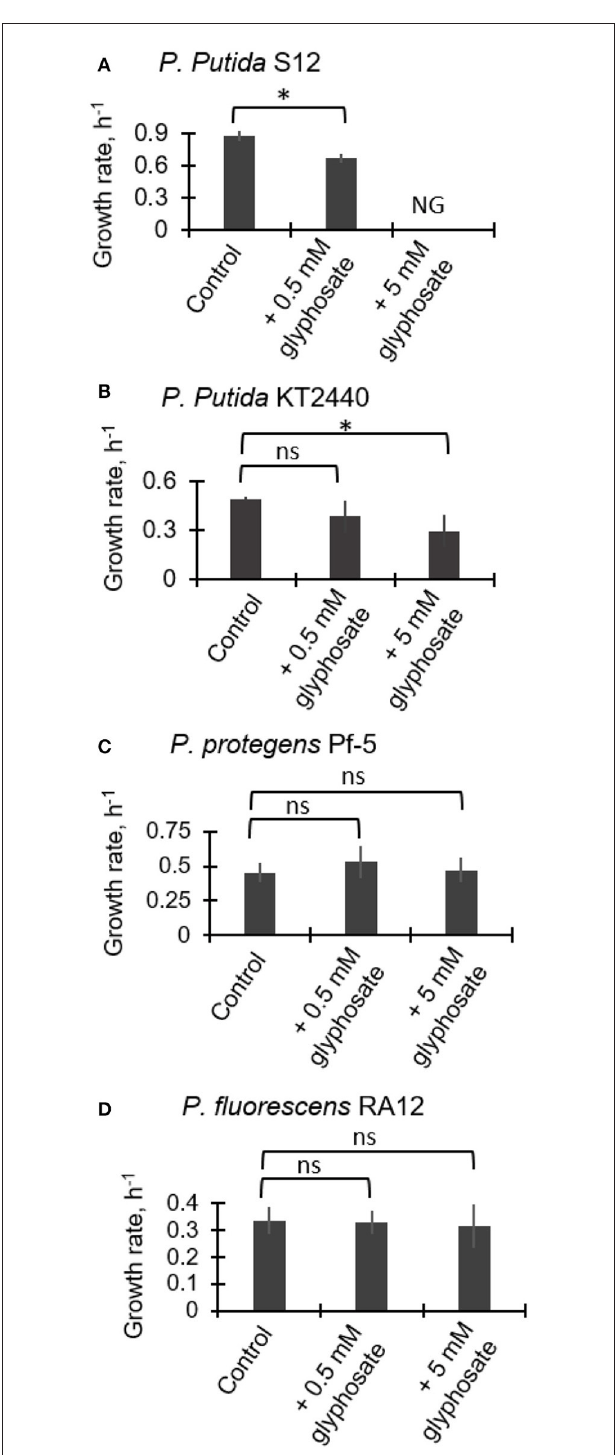
FIGURE 2 | Growth rates of succinate-grown Pseudomonas species in the absence (control) and presence of glyphosate (0.5mM and 5mM): (A) P. putida S12; (B) P. putida KT2440; (C) P. protegens Pf-5; (D) P. fluorescens RA12. Abbreviation for (B) : NG, no growth. The measured data were from three biological replicates ( n = 3). Two-tailed unpaired t- test analysis comparing the specific growth rate of the control experiment to the growth rates of glyphosate-exposed cells: p < 0.05 (*); ns, not statistically